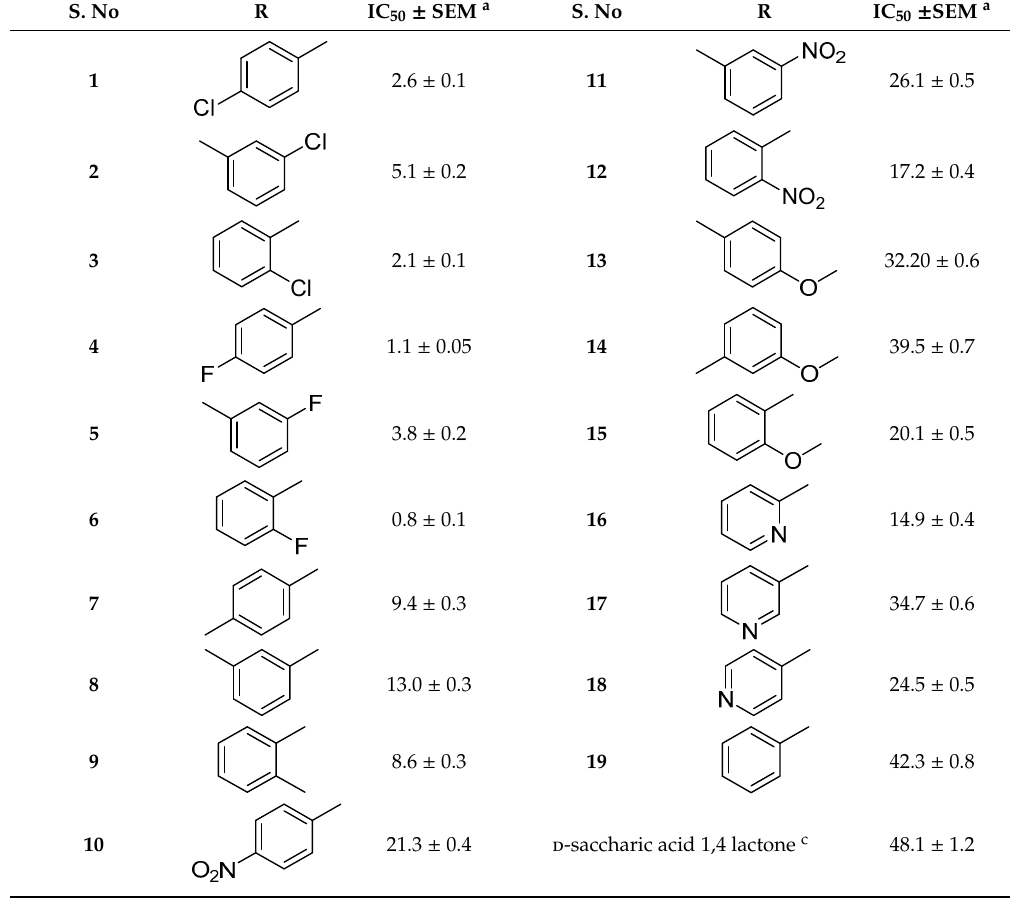
Table 1. Chromen-4-one based oxadiazole derivatives 1 – 19 .